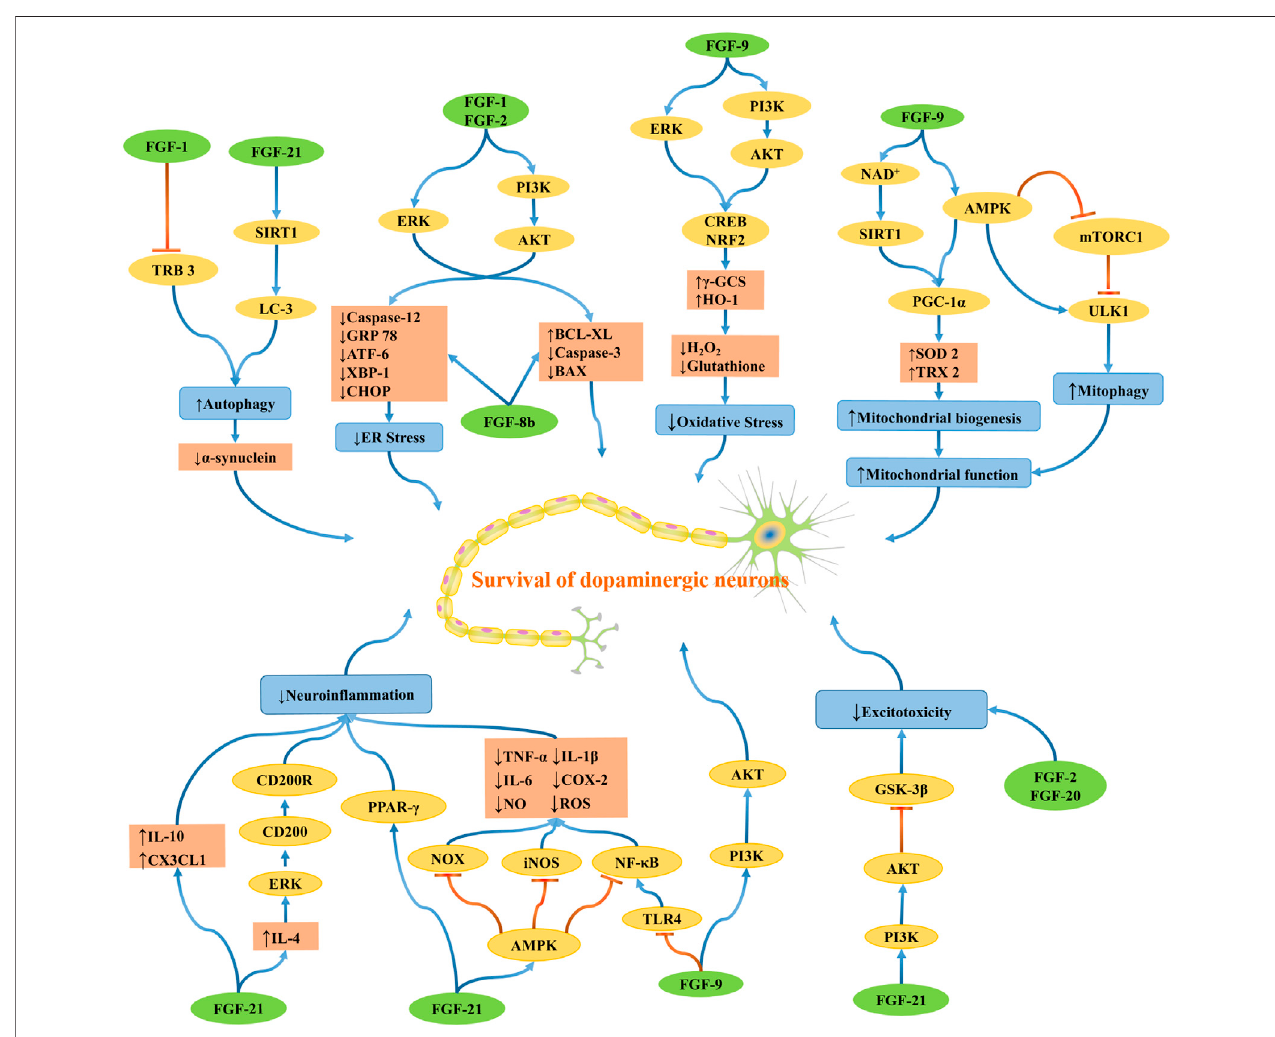
FIGURE 4 | The schematic diagram depicts the molecular mechanisms by which FGF regulates oxidative stress, mitochondrial dysfunction, protein aggregation and misfolding, neuroin fl ammation, and excitotoxicity. Blue lines indicating positive effects, and red lines are indicating adverse effects.